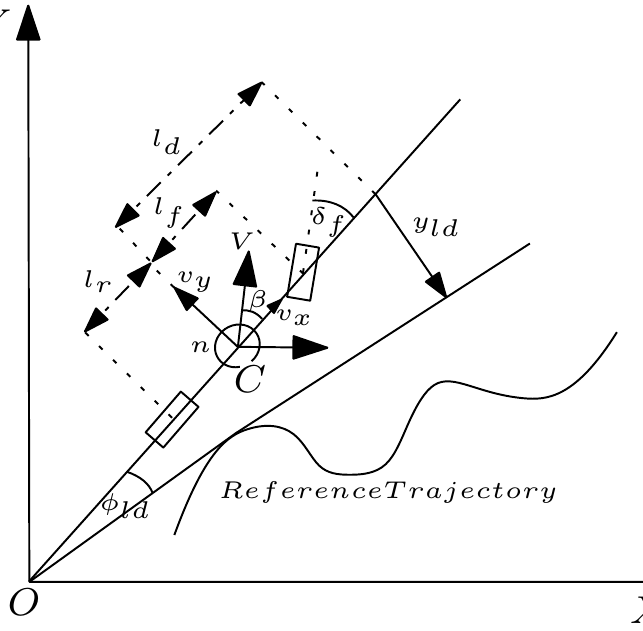
Figure 1. Combined vehicle dynamics and the kinematic